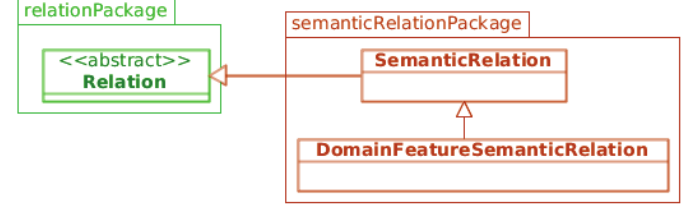
Figure 10: Semantic relation